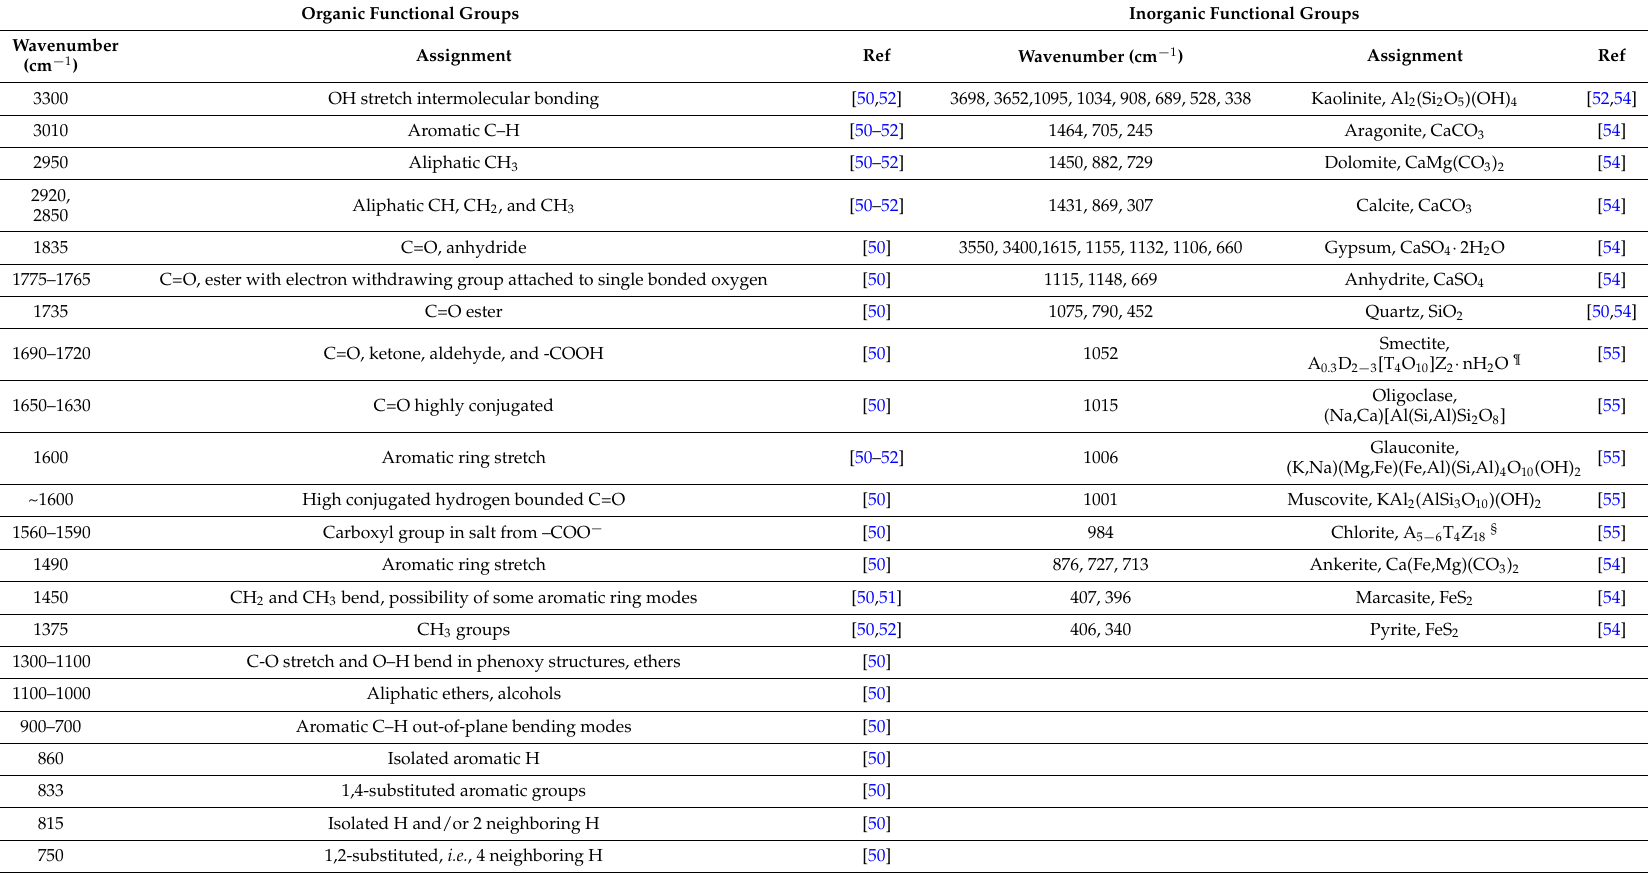
Table 1. Band assignments for the infrared spectra of coals